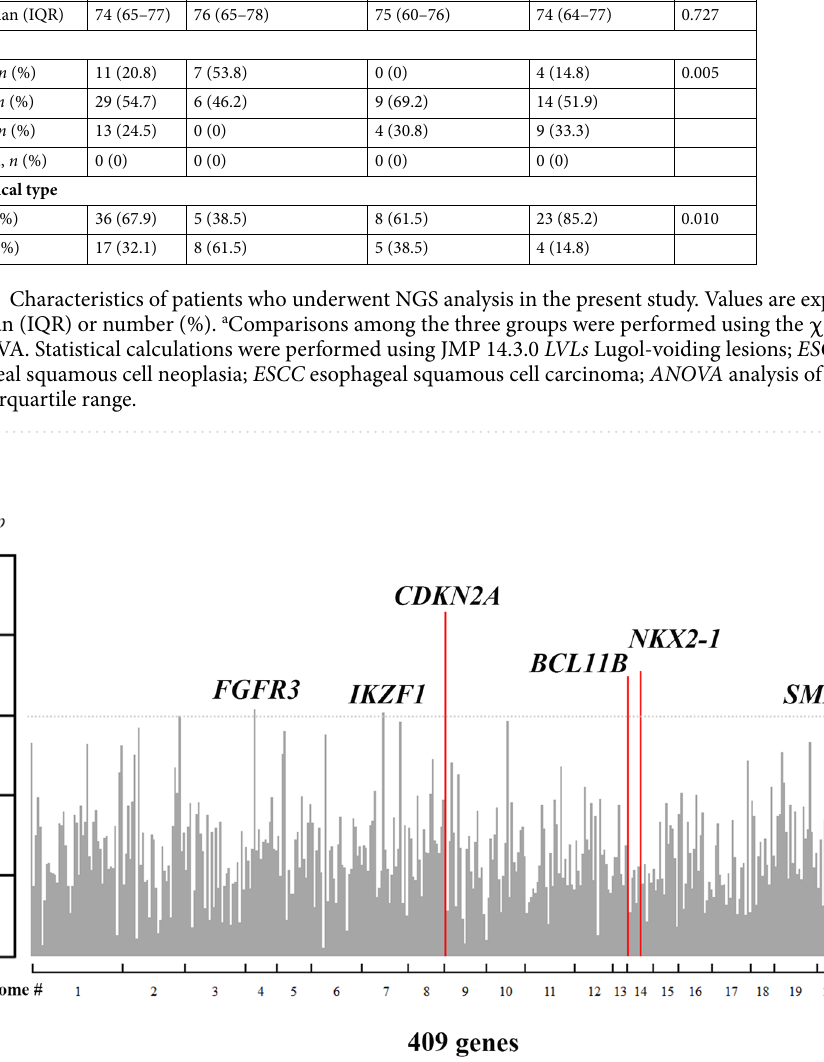
Figure 1. Differences in the frequency of somatic variants by risk factors. The number of variants in 409 genes was compared using ANOVA, with FDR < 0.05, among six groups, including somatic variants in neoplastic and adjacent non-neoplastic epithelium of the F-UR, F-KR, and M-KR groups. There was a significant difference in the frequency of CDKN2A ( p < 0.0001), NKX2-1 ( p = 0.0002), and BCL11B ( p = 0.0003) gene variants ( p < 0.001). Statistical calculations were performed using R programming language version 3.6.1. F-UR female unknown- risk; F-KR female known-risk; M-KR male known-risk; FDR false discovery rate; ANOVA analysis of